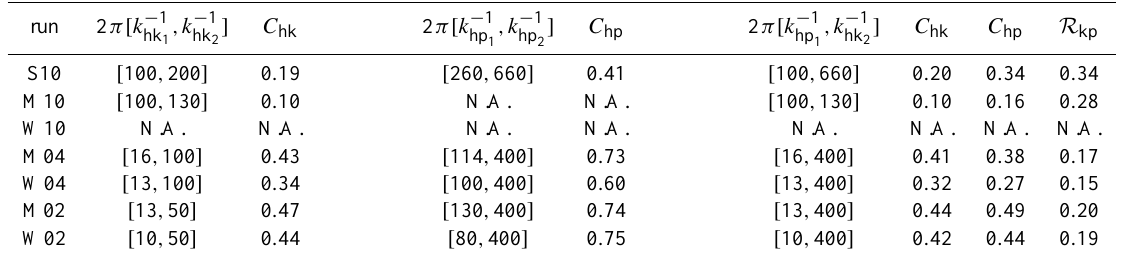
] , Eq. (58). N.A. means that no inertial range could be ,k hk 2 1